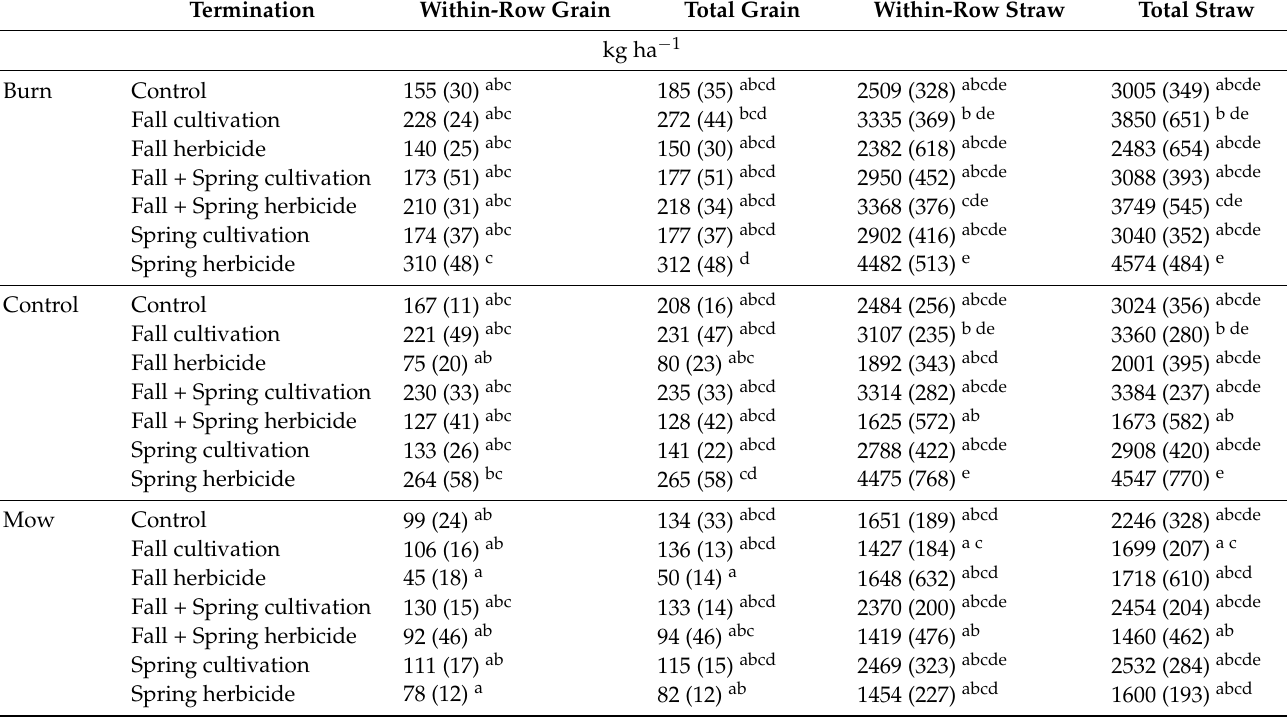
Table 4. Mean within-row and total grain and straw yield ( ± SE, n = 4) for suppression and termination treatment combinations in 2019. Different lower-case letters denote statistical significances between each suppression and termination treatment combination at p <